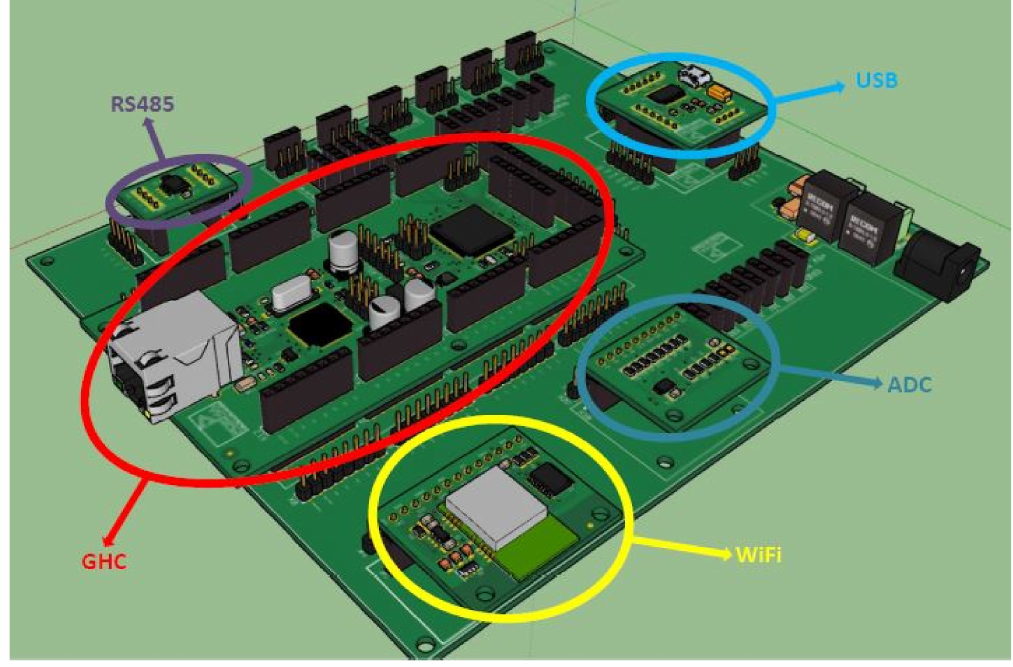
Figure 2. 3D view of the electronic